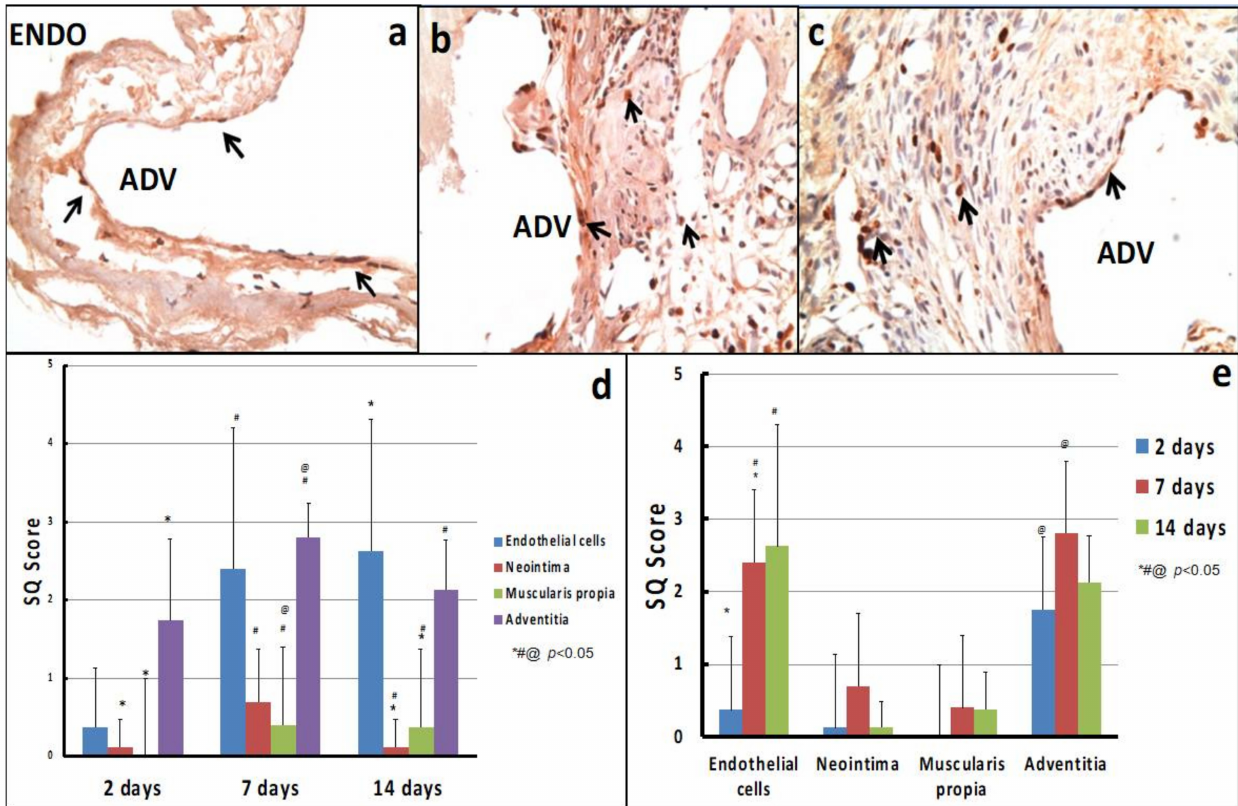
Figure 3. Cellular proliferation in the mouse AVF stenosis model: ( a – c ) show the immunohistochemistry for Ki-67 at 2 d, 7 d and 14 d, respectively. Note the early (2 d) and persistent (7 d and 14 d) presence of cellular proliferation in our mouse AVF stenosis model. ( d , e ) show our semi-quantitative scoring system for Ki-67 across different time points and different regions of the AV anastomosis. Small black arrows indicate proliferating cells; Endo = luminal side; Adv = adventitial